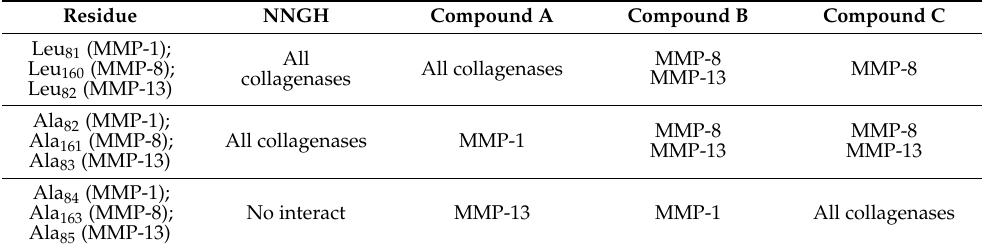
Table 3. Interactions between the residues Leu, Ala and Ala of the MMPs-1, -8 and -13 and the NNGH inhibitor and the compounds A, B and C.